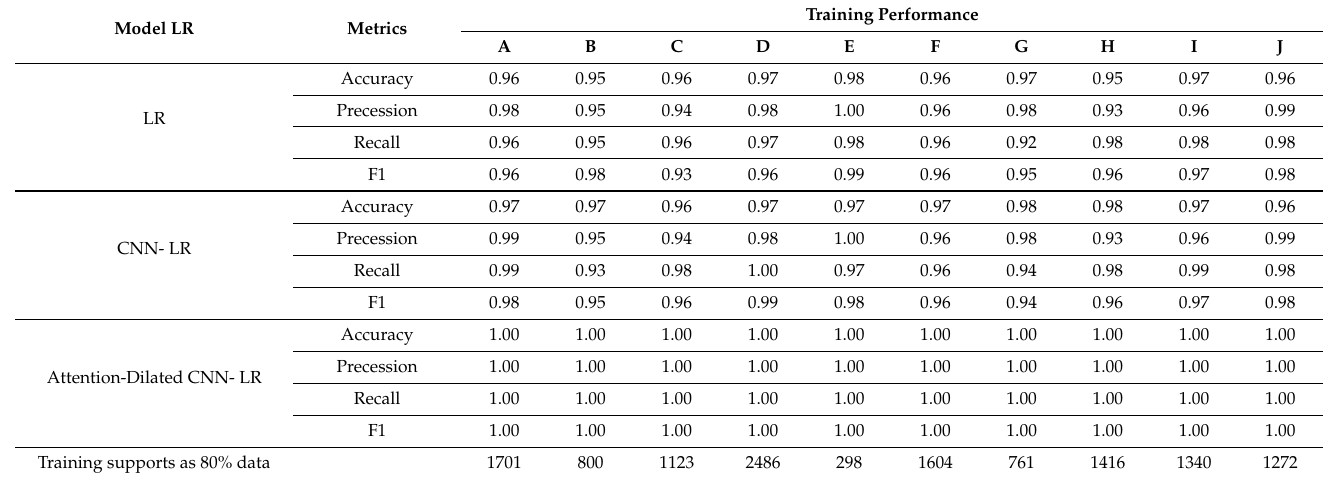
Table 3. Training performance of ADCLR model.